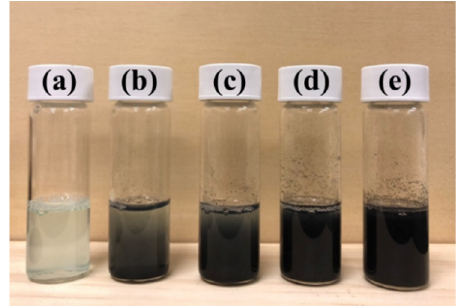
Figure 3. Digital photos of CuNPs/PTT/GO hybrid dispersions before reduction, the ratio of